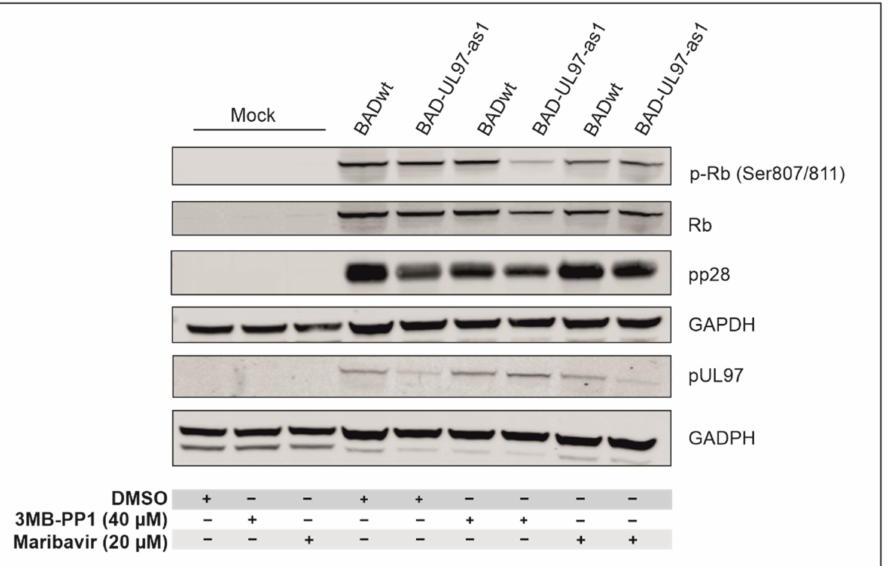
Figure 4. Phosphorylation of the retinoblastoma protein (Rb). Cells were pre-treated with DMSO, 3MB-PP1 or MBV one day before infection. The next day, cells were infected with BADwt or BAD- UL97-as1. Cells were harvested and lysed at 5 d.p.i. and analyzed in an SDS-PAGE and Western blot using a phospho-specific antibody for residues 807/811 of Rb. Antibodies against full protein Rb, the viral proteins pp28 and pUL97 were probed for